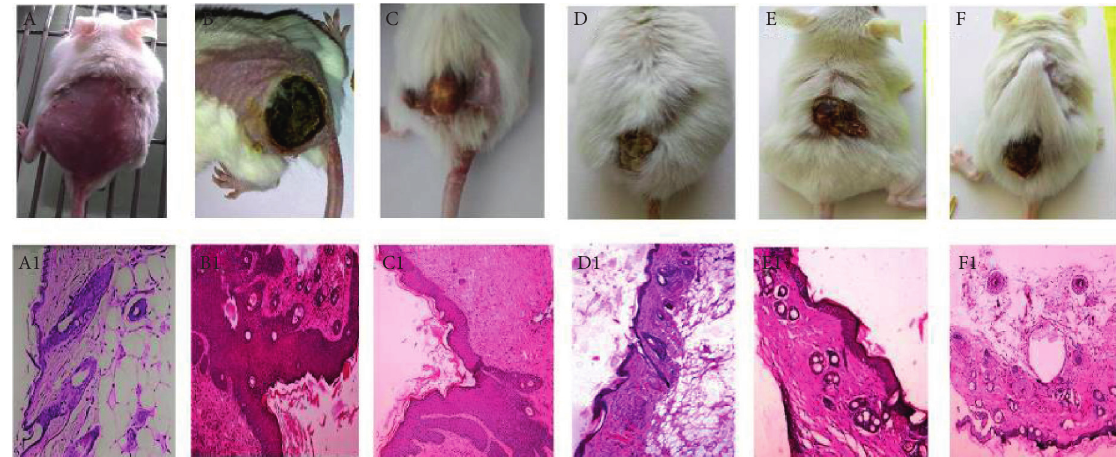
Figure 2: Representative images of the gross morphological appearance of mice skin tumors (a) untreated (nontumor control); (b) after 17 weeks of subcutaneous DMBA injection (untreated control); (c) after GNPs treatment; (d) after nisin-GNPs treatment; (e) after Dox-GNPs treatment; (f) after nisin-Dox-GNPs treatment for 7 weeks after skin tumor induction. Photomicrographs of histopathology that correspond